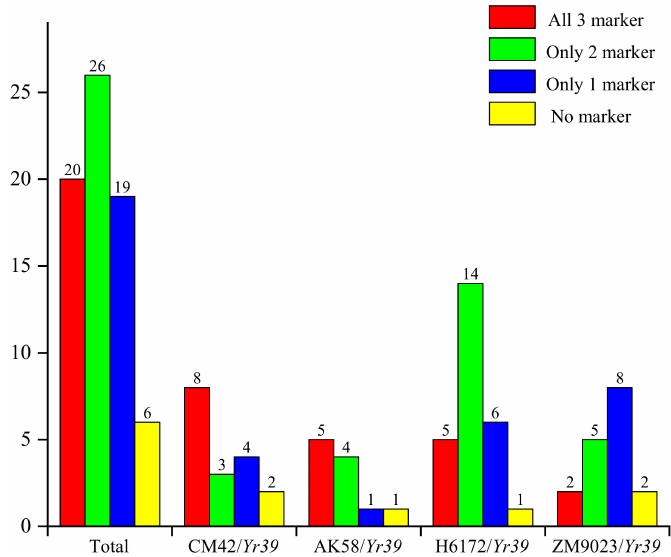
Figure 3. Statistics of marker detection results of 71 lines in 4 backcross progeny